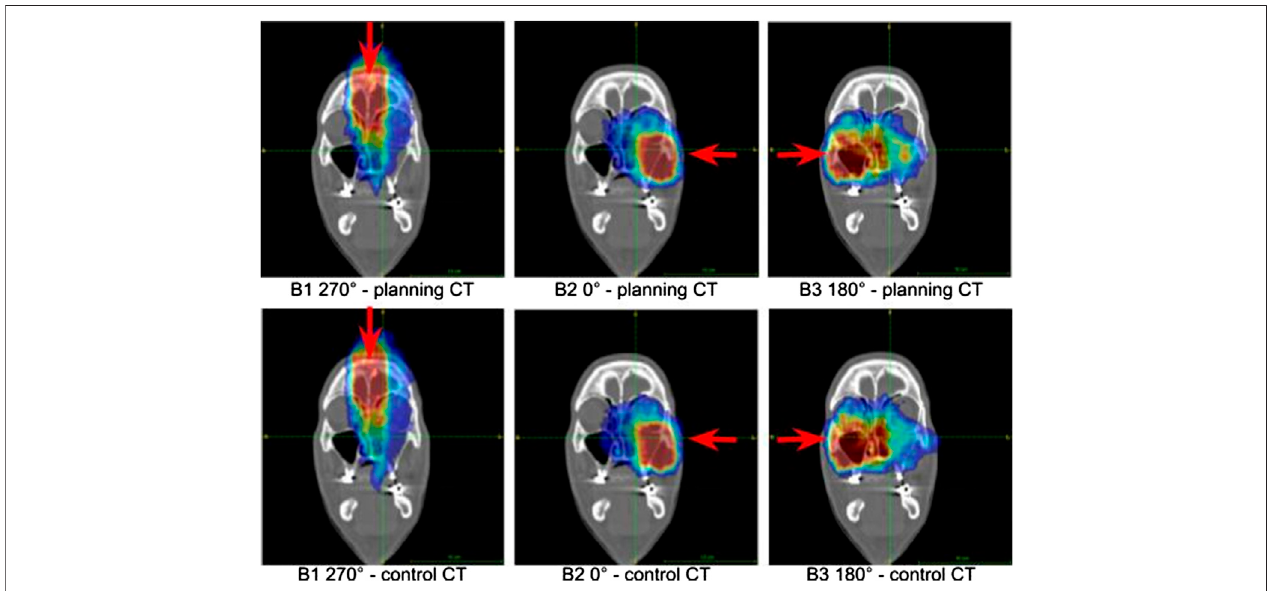
FIGURE4| Coronalsectionsoftheactivityimagesofthesimulatedpatientattheisocenter. Upperrow: imagesobtainedbyconsideringtheplanningCTintheMC simulation. Bottom row: images referring to the MC simulation in which the control CT was taken into account. The beam fi elds (B1, B2, B3) of the treatment are reported. The beam direction is identi fi ed by the red